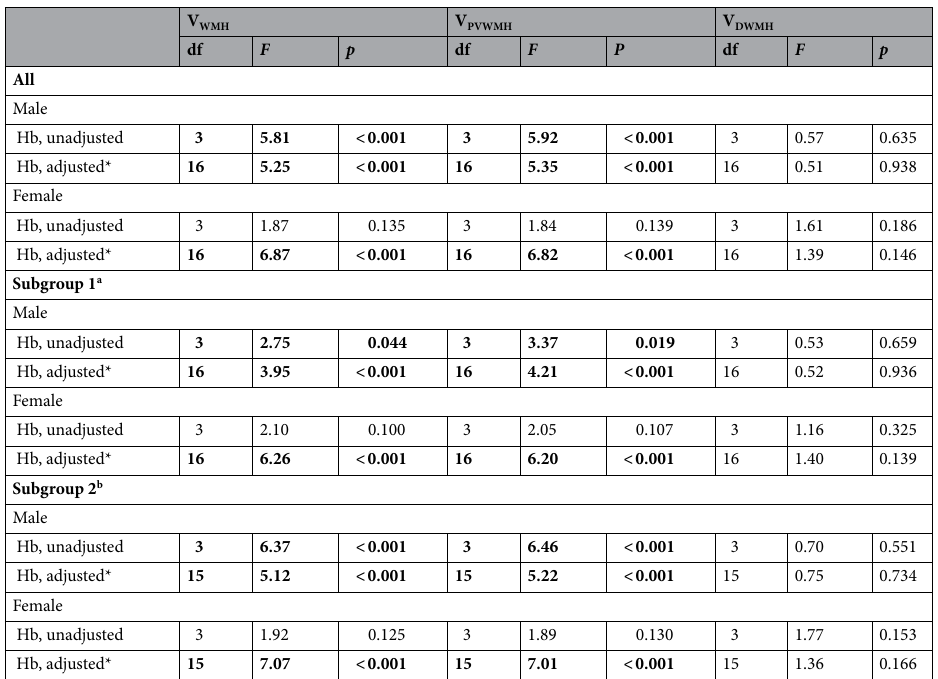
Table 3. Restricted cubic spline model for association between serum free hemoglobin level and white matter hyperintensity volume. Hb hemoglobin, V WMH volume of total white matter hyperintensity, V PVWMH volume of periventricular white matter hyperintensity, V DWMH volume of deep white matter hyperintensity. *Adjusted for age, hypertension, diabetes, stroke, cumulative illness rating sore, drinking status, smoking status, systolic blood pressure, body mass index, total cholesterol level, high-density lipoprotein cholesterol level, glomerular filtration rate, and cohort; the stroke was not adjusted as a covariate for the analysis of subgroup 2. a Participants without anemia or iron supplementation. b Participants without a history of stroke. Significance values are given in